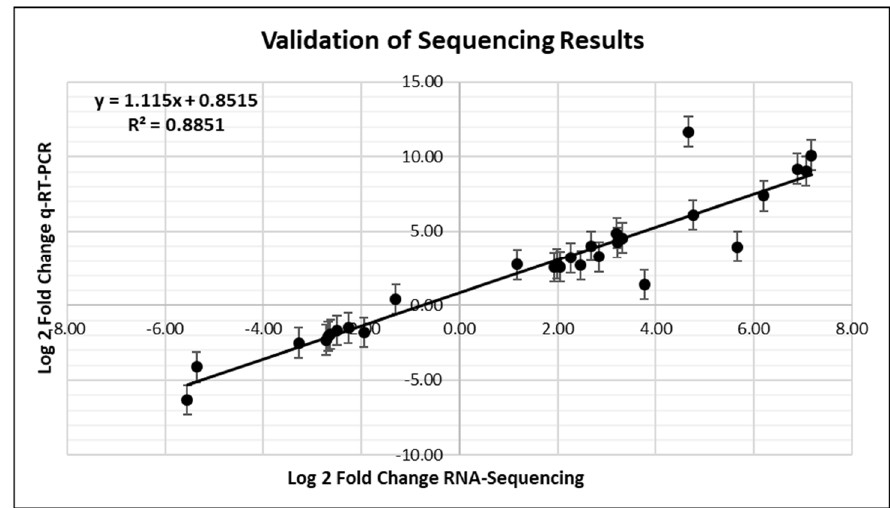
Figure 7. qRT-PCR validation of the RNA-Seq results of Lolium temulentum in response to drought/heat. Correlation between the relative quantification between control and heat/drought treated samples at 12, 24, and 48 h time points obtained through RNA-Seq analysis (log 2 fold changes) and qRT-PCR analysis (log 2 fold changes with standard error bars). Regression line and correlation coefficient are shown on the graph. Data are presented in Supplementary Table S4.